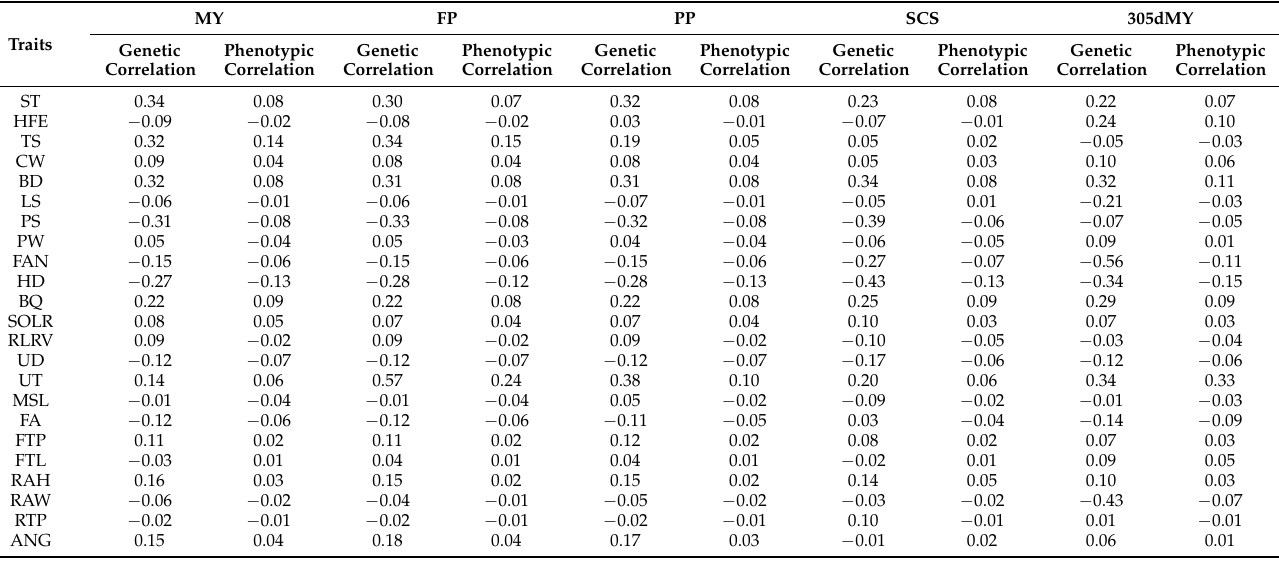
Table 6. Genetic and phenotypic correlations between conformation traits and milk production traits in Chinese Holsteins 1